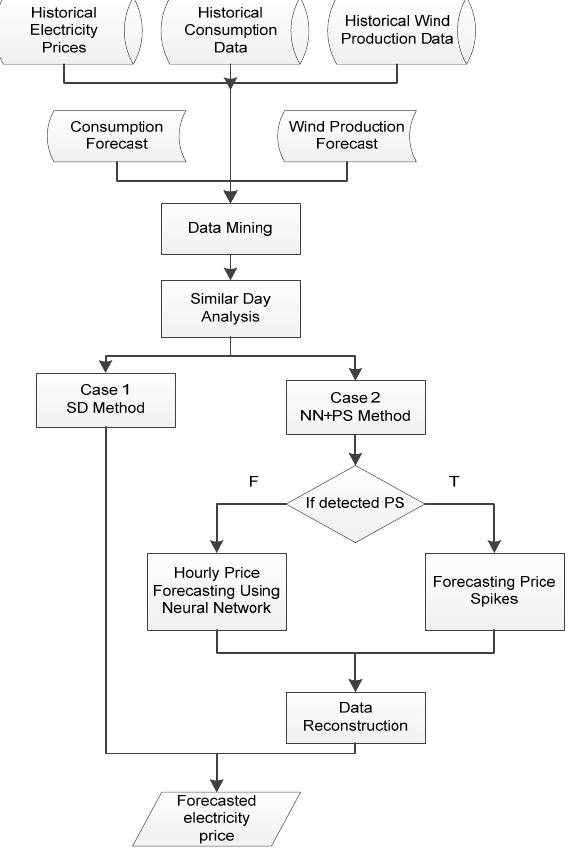
Figure 2. Flow chart of the hybrid electricity price forecasting